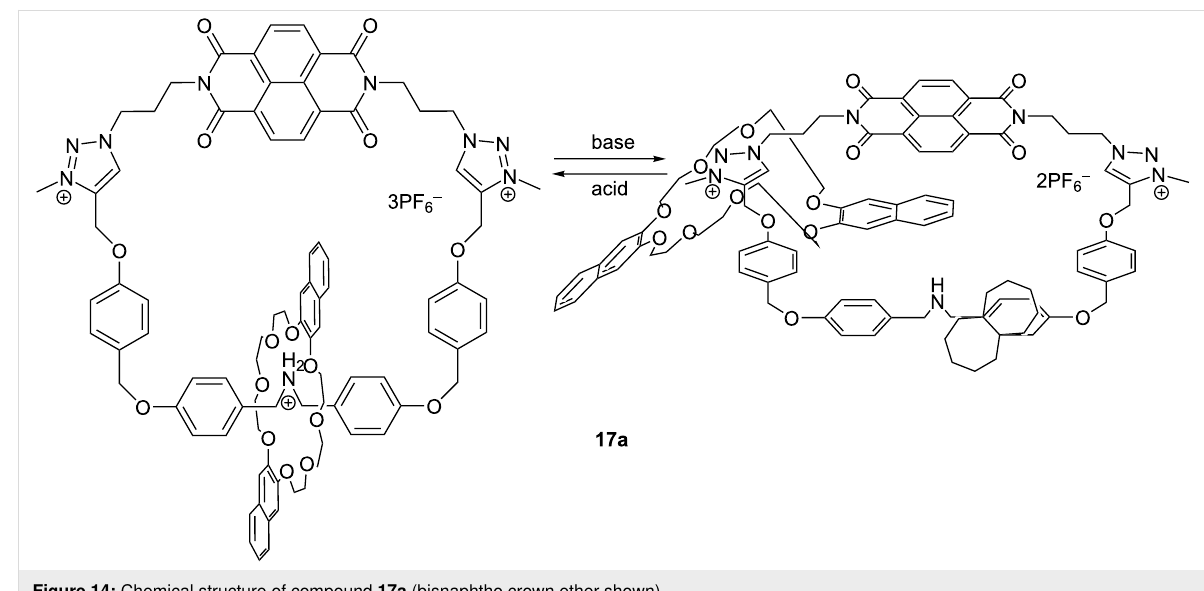
Figure 14: Chemical structure of compound 17a (bisnaphtho crown ether shown).